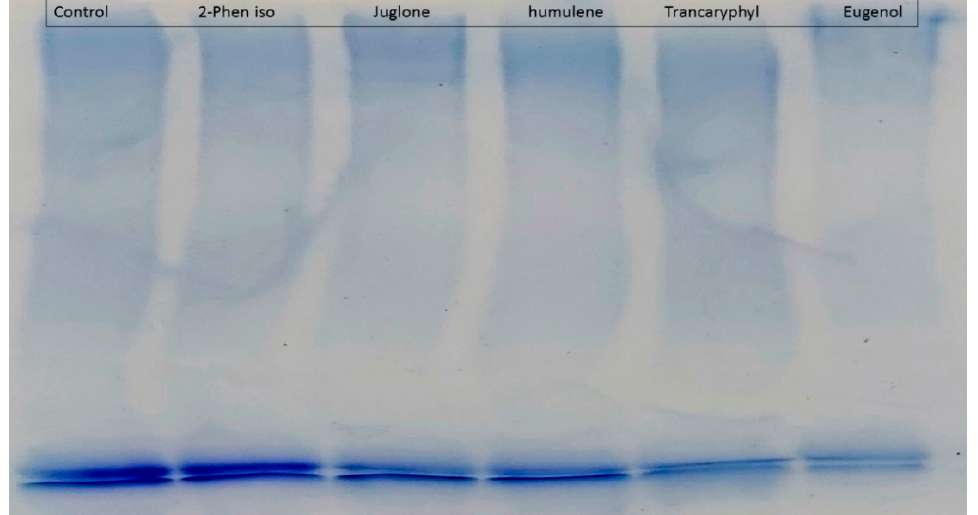
Figure 6. Gel showing BSA-Glucose glycation with tested compounds.